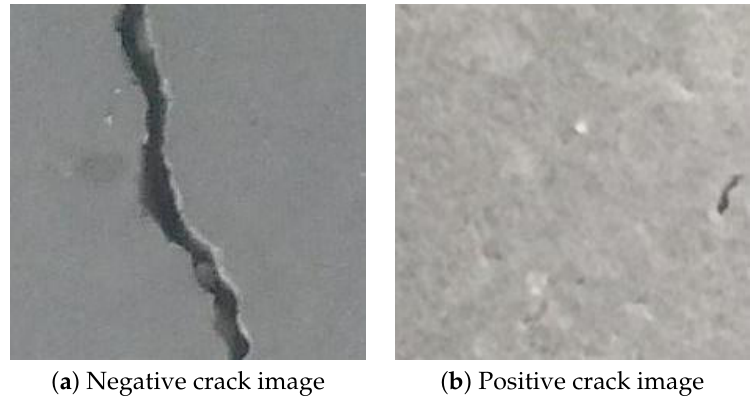
Figure 4. Sample images of the concrete crack dataset.